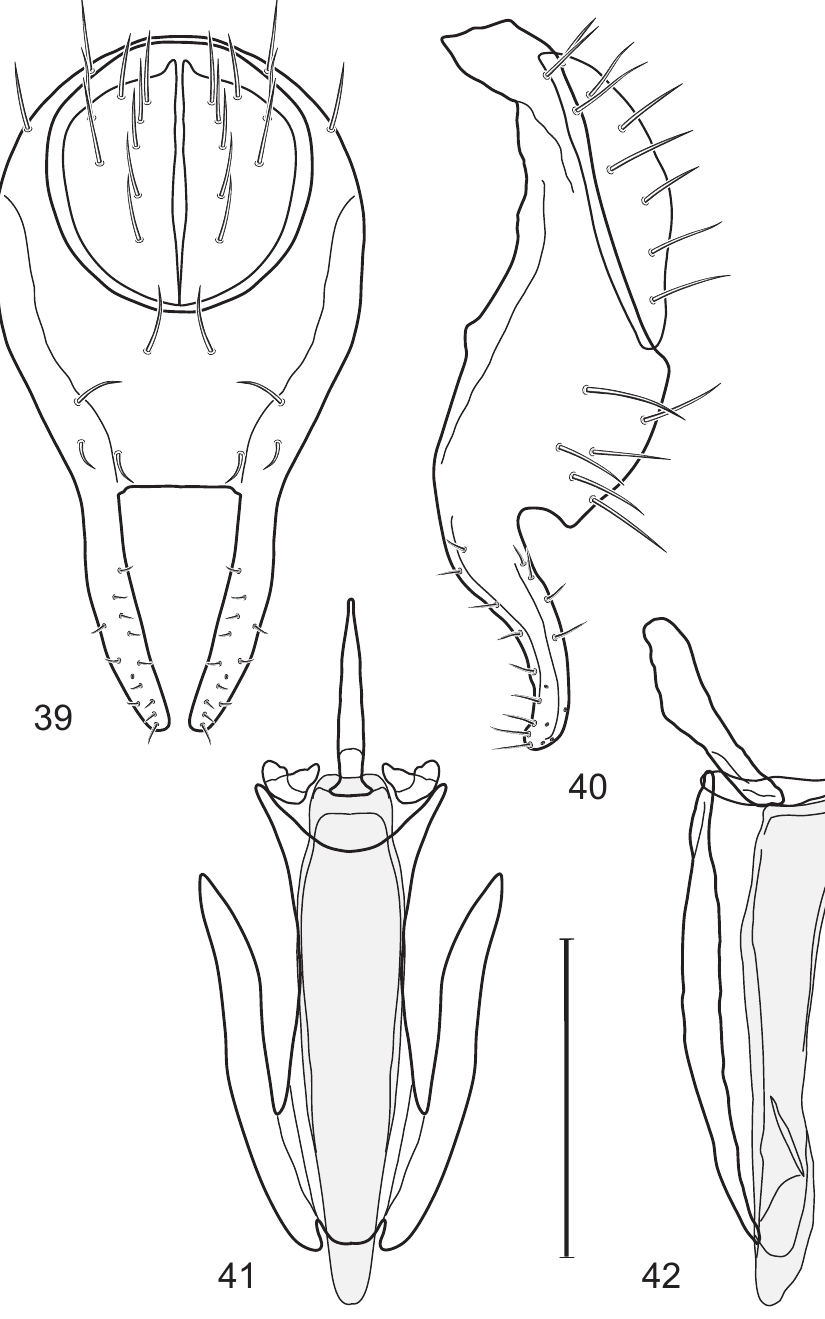
Figures 39–42. Hydrochasma sinuatum sp. n. (Mexico. Sinaloa: 13 km NE of Concordia) 39 epandrium and cerci, posterior view 40 same, lateral view 41 internal structures of male terminalia (aedeagus [shaded], phallapodeme, gonite, hypandrium), ventral view 42 same, lateral view. Scale bar = 0.1